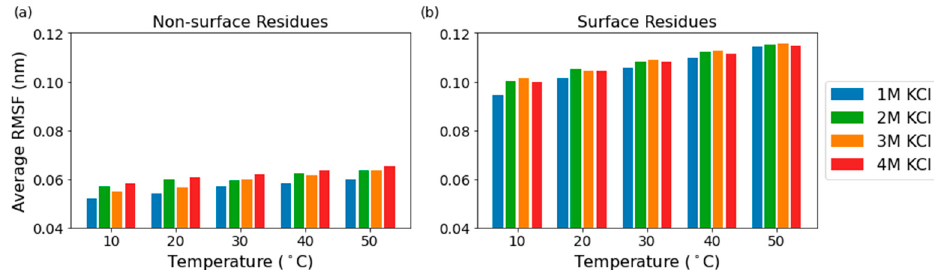
Figure 5. Average RMSF of the non-surface residues ( a ) and the surface residues ( b ).